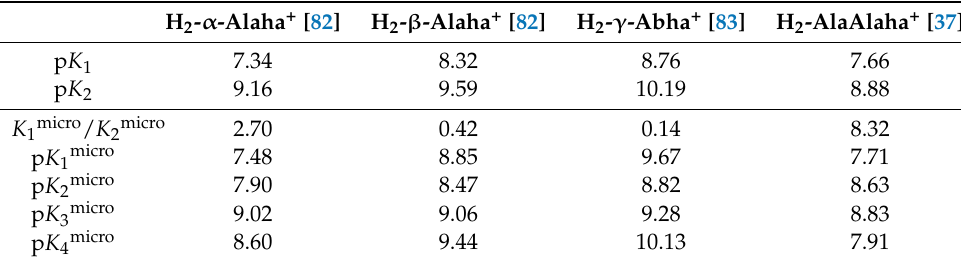
Table 1. Dissociation macro constants (p K i ) and micro constants (p K imicro ) of some selected amino and peptidehydroxamic acids at 25.0 °C (I = 0.20 M KCl).